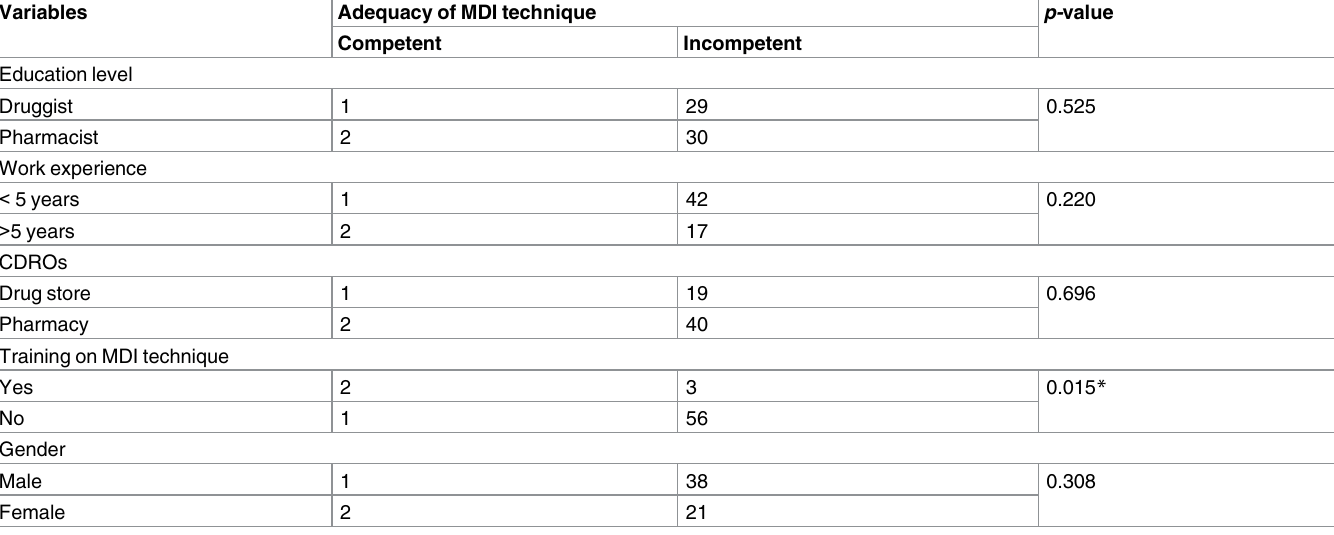
Table 3. Fisher exact test to explore potential predictors of competency of adequate inhalational technique,